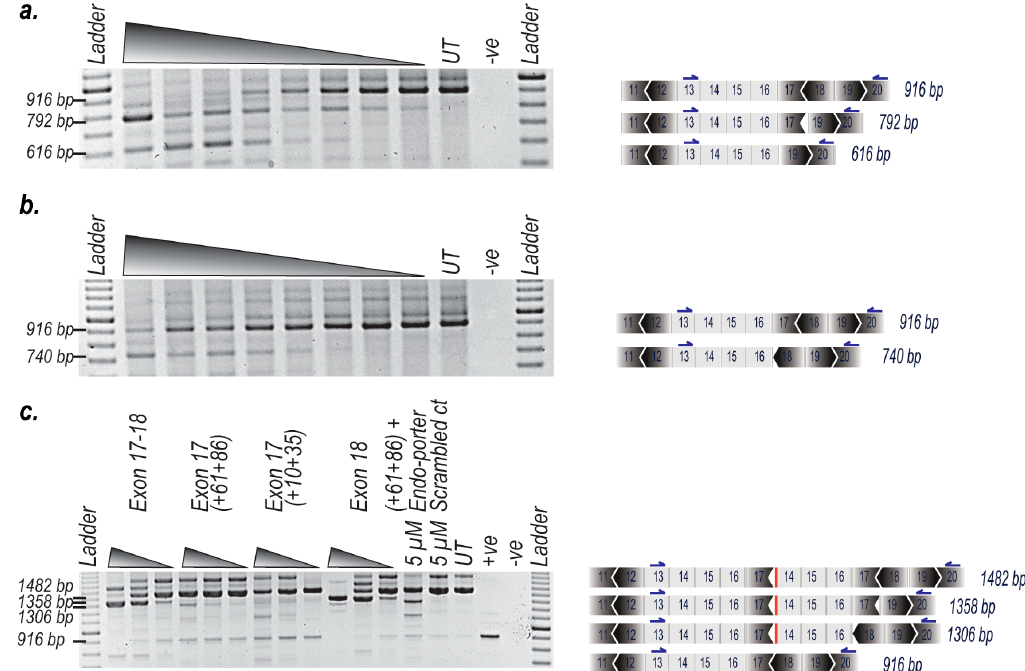
Figure 2. AO-induced excision of exons 17 and 18 from the DMD transcript in primary myogenic cells derived from a healthy donor and from a dystrophic patient with a duplication of exons 14–17, after transfection with phosphorodiamidate morpholino oligomer coupled to a cell penetrating peptide (PPMO) and / or phosphorodiamidate morpholino oligomer (PMO). Normal myogenic and dystrophic myogenic cells were transfected with PMO or PPMOs and incubated for 96 h. Total RNA was extracted, and RT-PCR was undertaken; ( a ) RT-PCR of RNA from normal myogenic cells transfected at concentrations of 5 µ M, 1 µ M, 800 nM, 400 nM, 200 nM, 100 nM, 50 nM and 25 nM with PMO and PPMO targeting exons 17 (H17A ( + 61 + 86)) and exon 18 (H18 ( + 24 + 53)) (RT-PCR was undertaken across exons 13–20. Transcript product sizes; full length is 916 bp, deletion of exon 18 is 792 bp and deletion of exon 17 and 18 is 616 bp); ( b ) RT-PCR of RNA from normal myogenic cells transfected at the concentrations of 5 µ M, 1 µ M, 800 nM, 400 nM, 200 nM, 100 nM, 50 nM and 25 nM with PMO targeting exon 17 (H17A ( + 61 + 86)) (RT-PCR was undertaken across exons 13–20. Transcript product sizes; full length is 916 bp and deletion of exon 17 is 740 bp); ( c ) RT-PCR of RNA from exon 14–17 duplication cells transfected at the concentrations of 5 µ M, 800 nM and 200 nM with PMOs targeting exon 17 and / or exon 18 PPMO (RT-PCR was undertaken across exons 13-20. Transcript product sizes; full length is 1482 bp, deletion of exon 18 is 1358 bp, deletion of exon 17 is 1306 bp and the normal sized product is 916 bp); UT: amplicon from untreated exon duplication cells; + ve: amplicon from untreated normal cells; -ve: no template PCR negative control.